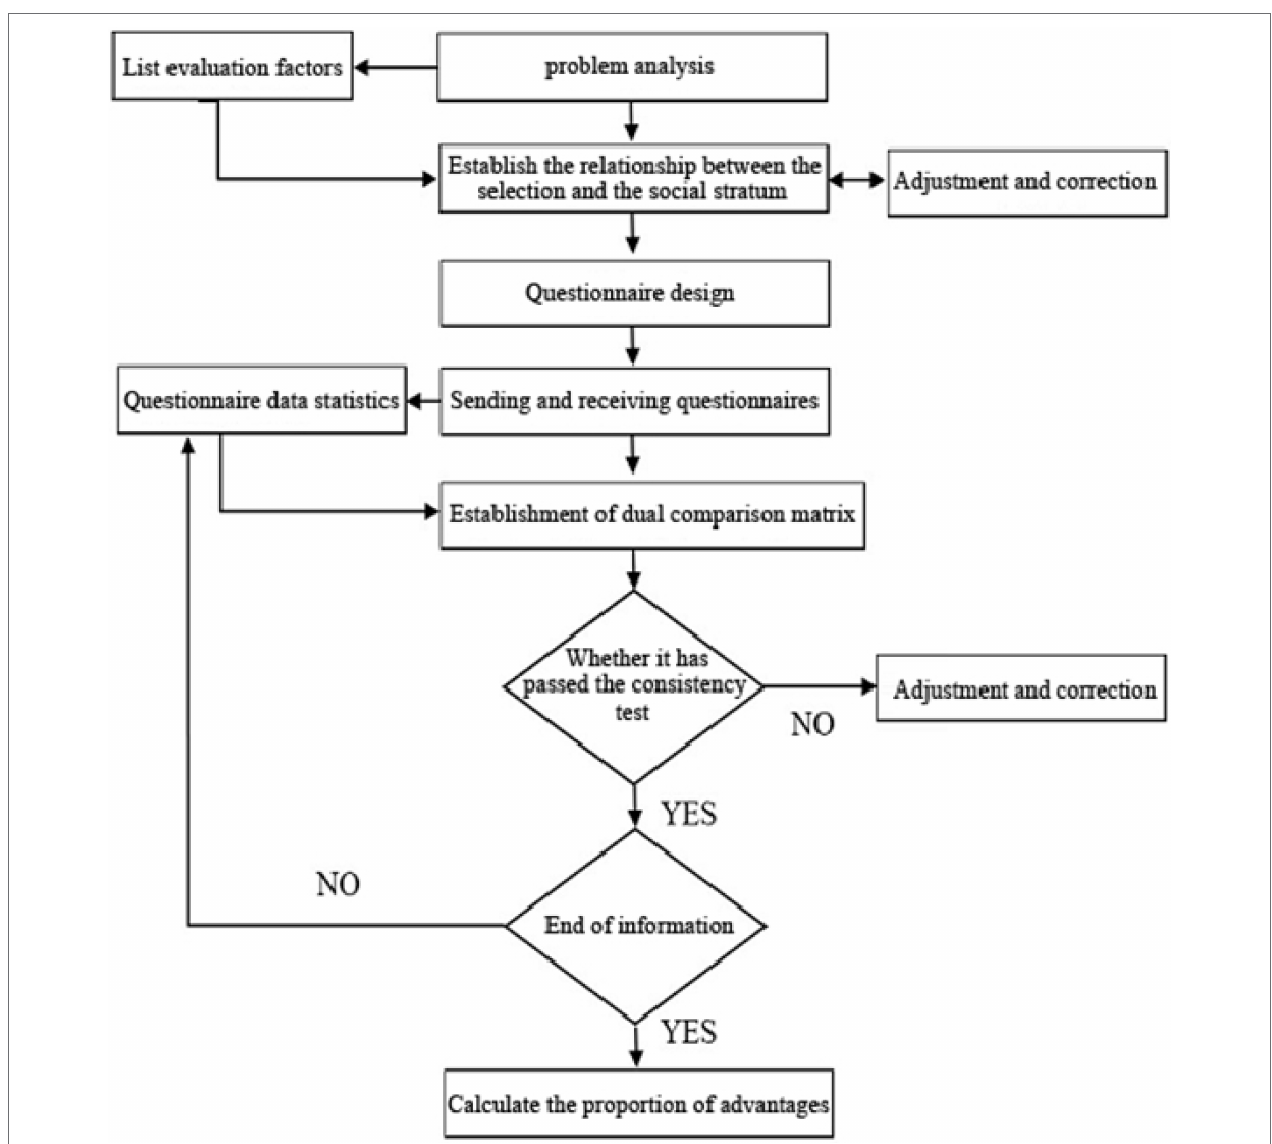
FIGURE 1 | Operation process of AHP